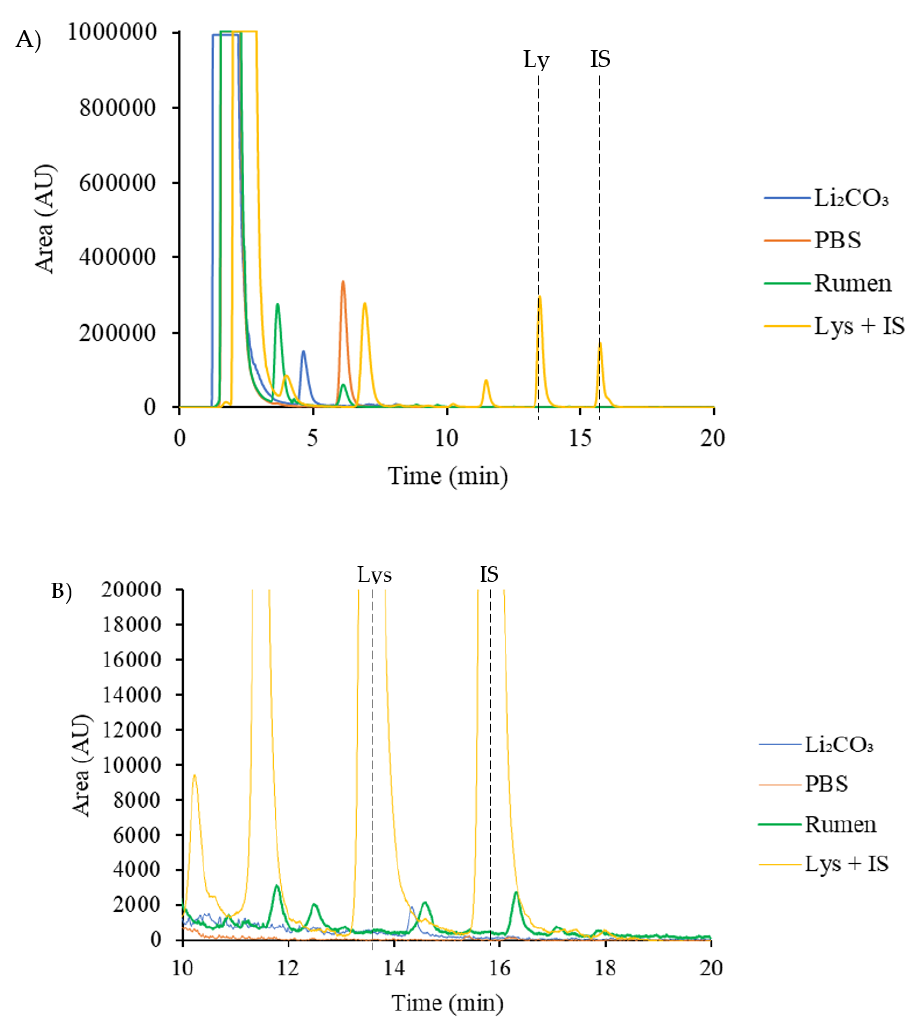
Figure 1. Chromatogram of Li 2 CO 3 buffer, phosphate buffer solution (PBS), and rumen fluid and lysine (Lys), with internal standard (IS) in Li 2 CO 3 buffer, showing the entire run length ( A ) and a zoomed in interval, relevant for Lys quantification ( B ).